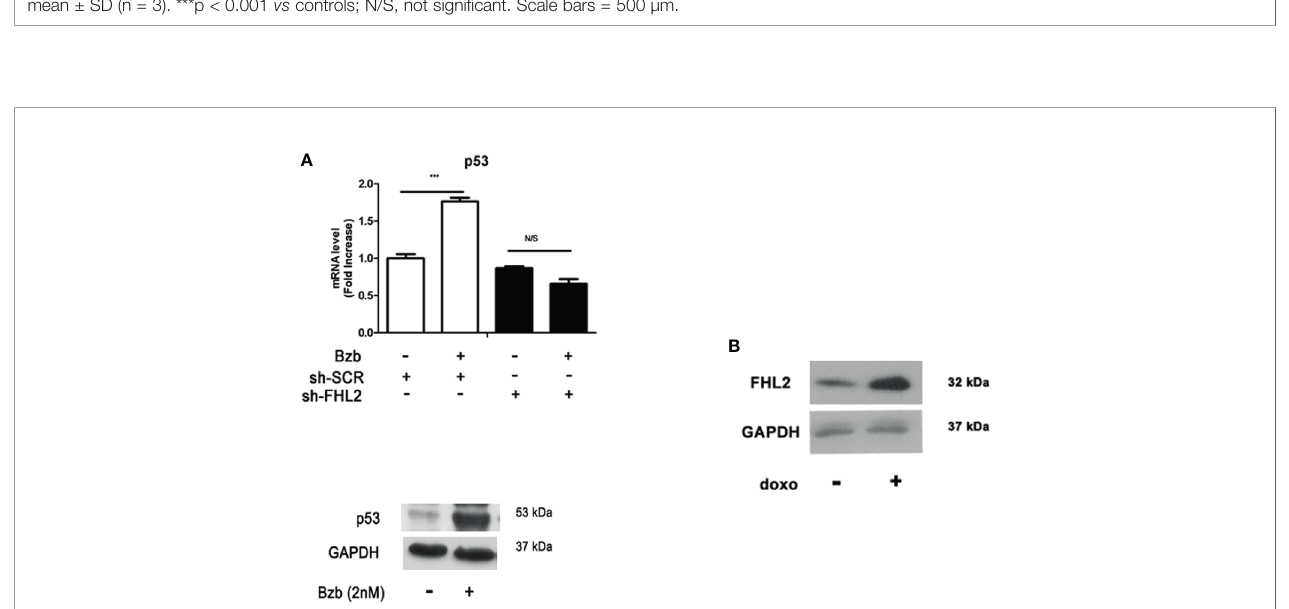
FIGURE 3 | p53 signaling is associated with Bzb-induced FHL2 upregulation. (A) MM-MSCs infected with shFHL2 and shSCR were differentiated in the presence or absence of Bzb (2 nM) for 7 days; the mRNA levels of TP53 were assessed by quantitative RT-PCR (up) and Western blot (blow). (B) The protein level of FHL2 was measured after 1 µg/ml doxorubicin (doxo) treatment for 24 h. Results are expressed as mean ± SD (n = 3). ***p < 0.001 vs . controls; N/S, not signi fi